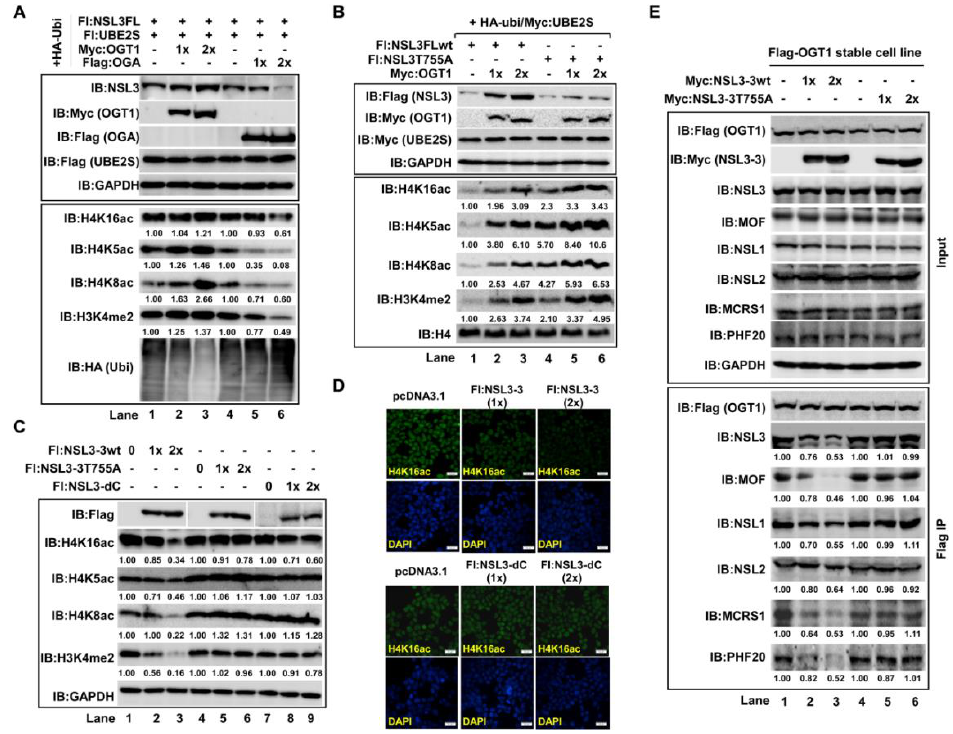
Figure 6. O -GlcNAc modification at NSL3 Thr755 site was required for maintaining the integrity of NSL complex and its holoenzyme activity. “ + , − ” in figures caption means with or without. ( A ) OGT1 / O -GlcNAcylation mediated changes in global histone H4 acetylation and H3K4me2: increasing amounts of OGT1 or OGA were co-transfected with NSL3 into 293T cells in the presence of UBE2S and HA-ubiquitin. Global histone H4 acetylation at lysine K5, K8, and K16 and H3K4me2 levels was detected with corresponding antibodies. Ubiquitin-mediated NSL3 degradation was visualized with anti-HA antibody. ( B – C ) E ff ects of NSL3T755 site O -GlcNAcylation on holoenzyme activity: increasing amounts of OGT1 were co-transfected with NSL3wt or NSL3T755A into 293T